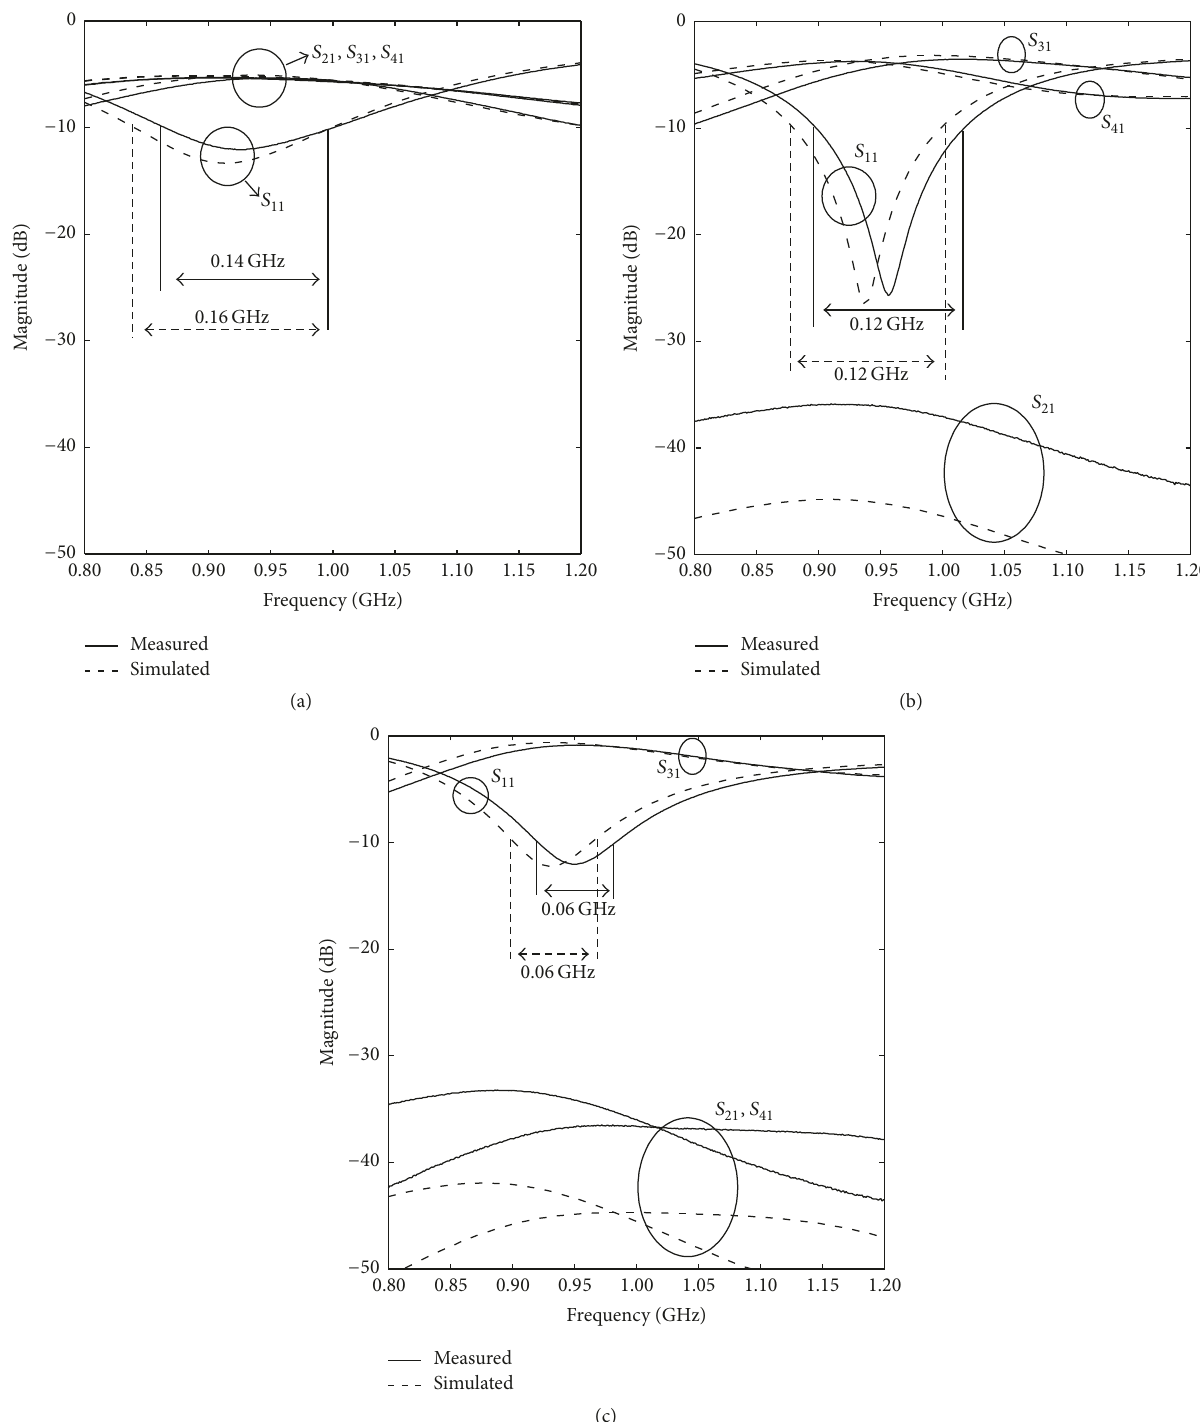
Figure 4: Simulated and measured results with (a) 0, (b) 2, and (c) 4 shorting